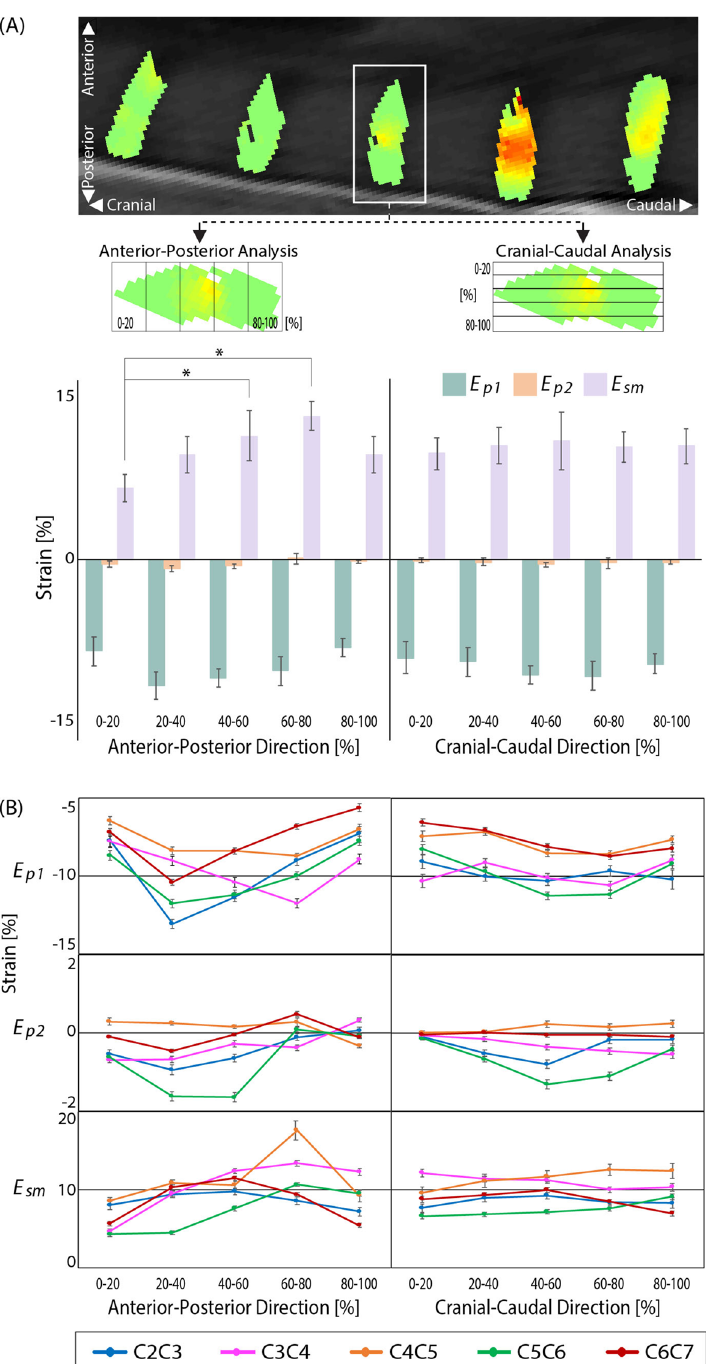
Figure 5. Within-disc analysis reveals increased E sm in the posterior regions of the IVD. To perform intratissue regional analysis, each IVD strain field was spatially divided (binned) into five equal sections (~ 50 voxels each) in anterior–posterior and cranio-caudal directions and averaged per disc. ( A ) Cervical discs (C2C3–C6C7) E p1 strains spatially varied in the anterior–posterior direction while E p2 strain differences were minimal. E sm strains were significantly increased (*p < 0.01) in the posterior (40–60% and 60–80%) locations compared to the anterior (0–20%) location. Analysis of the cranio-caudal strain regions revealed little variation (p > 0.01) for all strain measures ( E p1 , E p2 , E sm ). ( B ) The anterior–posterior and cranio-caudal segmentation of each disc separated by IVD indicates varying anterior–posterior responses in each IVD for all strains ( E p1 , E p2 , E sm ) while the cranio- caudal responses were more uniform. Error bars represent